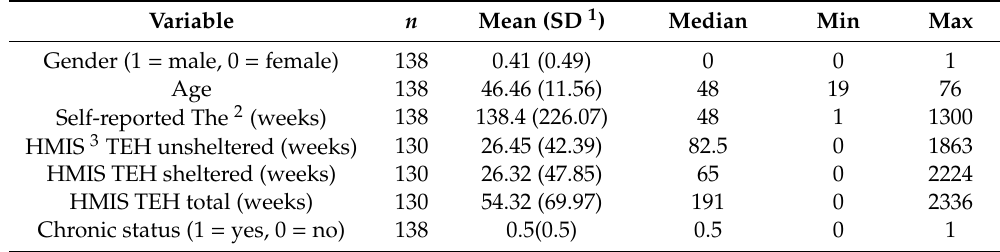
Table 1. Summary statistics for independent